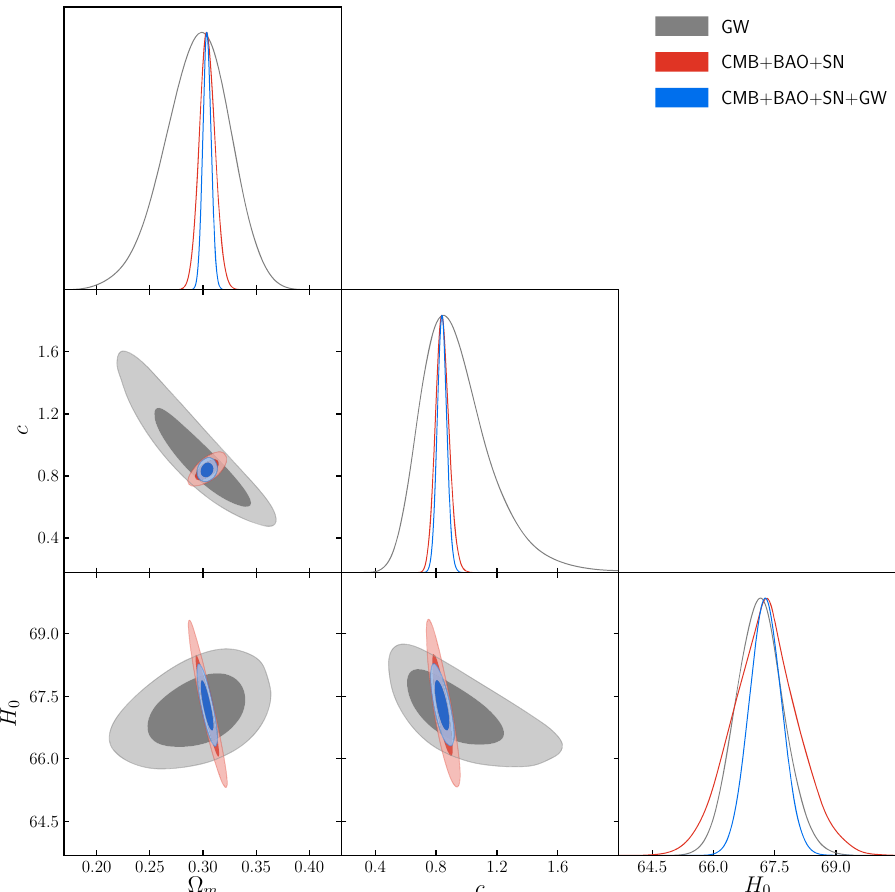
Fig. 3 Observational constraints (68.3% and 95.4% confidence level) on the HDE model by using the GW, CMB + BAO + SN, and CMB + BAO